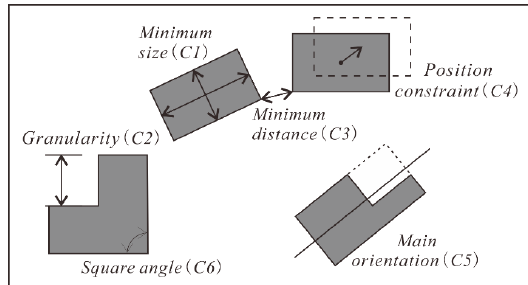
Figure 1. Local constraints acting on buildings.